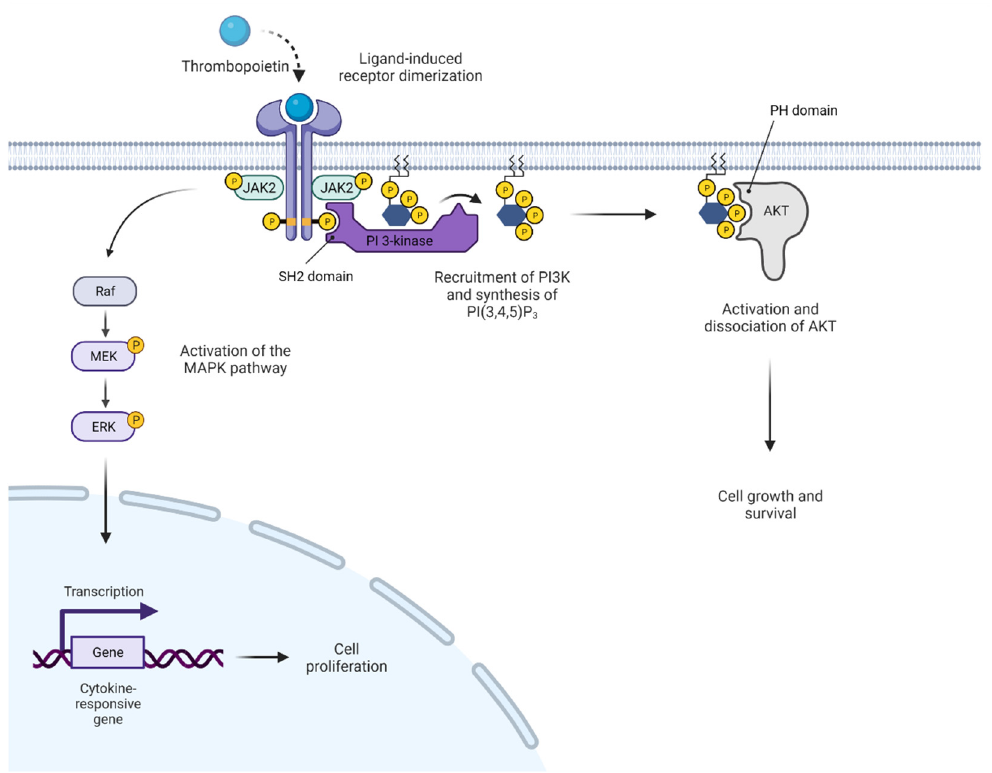
Figure 3. JAK2 signaling also activates MAPK and PI3K/Akt pathways, promoting cell prolifera- tion and survival.